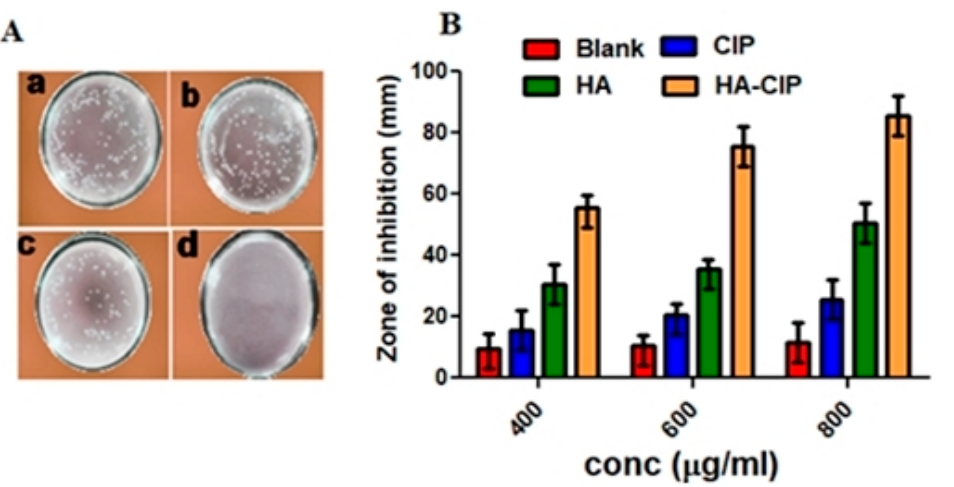
Figure 7. ( A ) Sterilizing effect on Salmonella typhi resistant strains via CIP, CIP-SNEDDS, HA- SNEDDS, and HA-CIP SNEDDS ( a – d ). ( B ) Zone of inhibition (ZOI) of SNEDDS formulation and CIP. Table 5. Results of in-vivo pharmacokinetic properties after oral delivery of CIP and HA-CIP SNEDDS to mice.